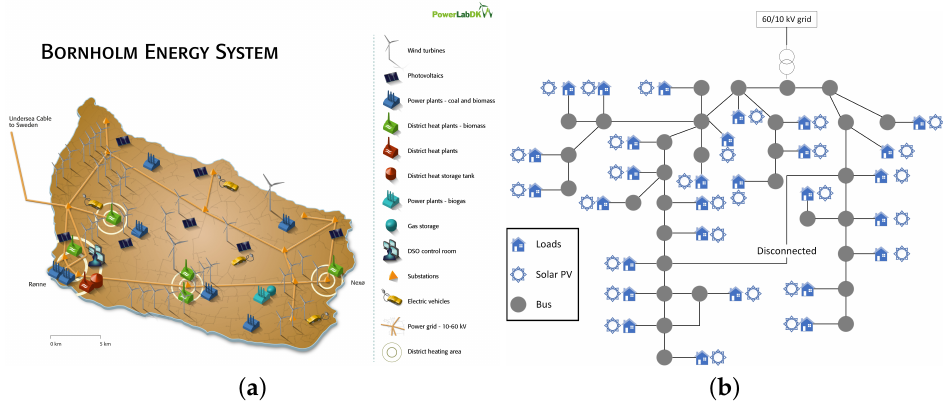
Figure 1. The demonstration of the Bornholm power system: ( a ) The 60 / 10 kV distribution grid; ( b ) An example low-voltage (LV) feeder in the Bornholm power system modeled in DIgSILENT